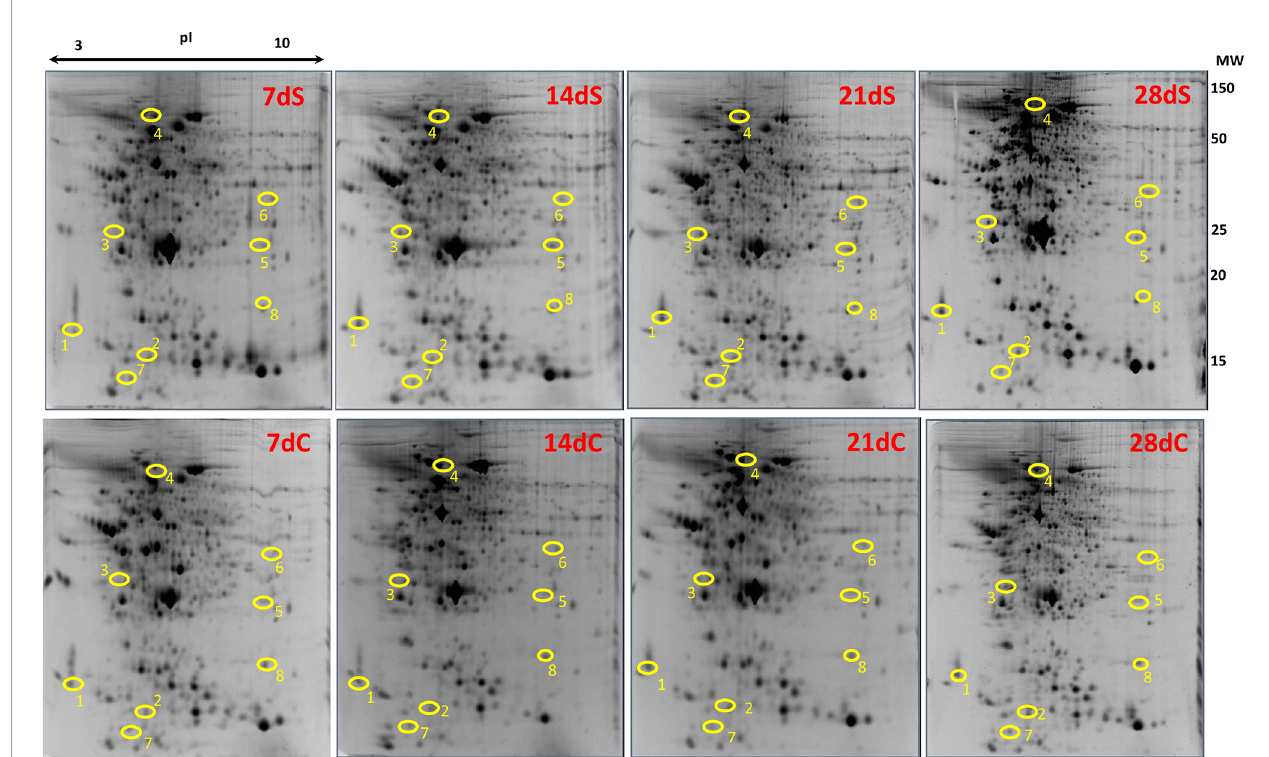
FIGURE 3 | Gel images from control and stressed groups showing differentially expressed proteins. Polyacrylamide gel (12.5%) images from 7, 14, 21, 28 days showing identi fi ed proteins from stressed and control fi sh. C stands for control and S stands for stressed group. Each gel represents proteins from one fi sh. Protein spots differentially expressed are encircled in yellow and denoted by numbers. 1- calmodulin, 2- fatty acid binding protein, 3- 14-3-3 alpha/beta, 4- heat shock cognate 70, 5- glutathione-S- transferase, 6- guanine nucleotide binding protein, 7- histone H4 and 8- keratin. Molecular weight (MW) measured in